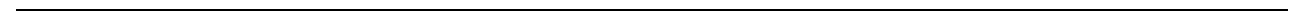
Fig. 8 miR-34a inhibition improves BPD phenotype via increased Ang1-Tie2 signaling. a Representative images of lung histology (H&E stain) of NB WT mice models of RA or BPD were treated with miR-34a inhibitor (20 µ M; PN2 and PN4) intranasal. Scale bar: 100 µ m. b , c Morphometric analyses of lung histology sections of NB WT mice miR-34a inhibitor at PN14. Alveolar size expressed as chord length and septal thickness. d Representative graph shows TUNEL-positive cells (%) in NB WT mice lungs treated with miR-34a inhibitor or control. e Western blot analysis of cleaved and total Caspase 3 was performed on MLE12 cells transfected with miR-34a inhibitor or scrambled control. f , g Bar graphs showing BAL neutrophils count and myeloperoxidase activity in RA and BPD mice treated with miR-34a inhibitor or scrambled control. h , i Bar graphs showing lung IL-1 β and IL-6 in RA and BPD mice treated with miR-34a inhibitor or scrambled control. j Representative immunohistochemistry (IHC) images showing increased staining of PCNA in miR inhibitor treated PN4 hyperoxia exposed animals. Scale bar: 100 µ m. k Western blot shows increased Ang1 and Tie2 in miR-34a inhibitor treated PN4 lung samples. BPD: bronchopulmonary dysplasia; Ang1: angiopoietin 1; NB: newborn; WT: wild-type; RA: room air; PN: postnatal; IL: interleukin. Values are means + SEM of a minimum of four observations (in vitro experiments) or four animals (in vivo experiments) in each group. * P < 0.05, ** P < 0.01, *** P < 0.01, compared with controls, 1-way